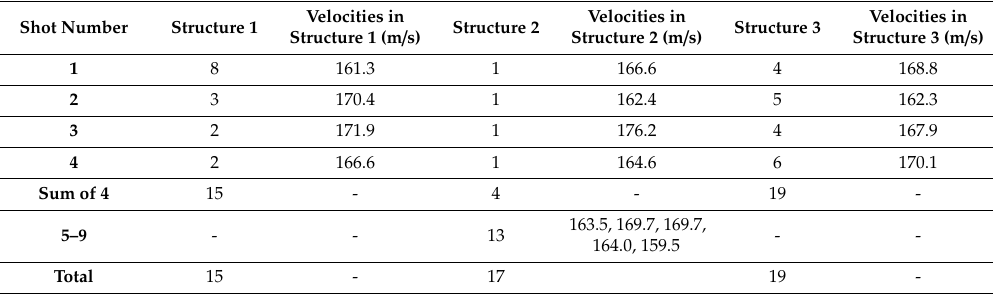
Table 5. Increased number of damaged ceramic tiles in impact tests.